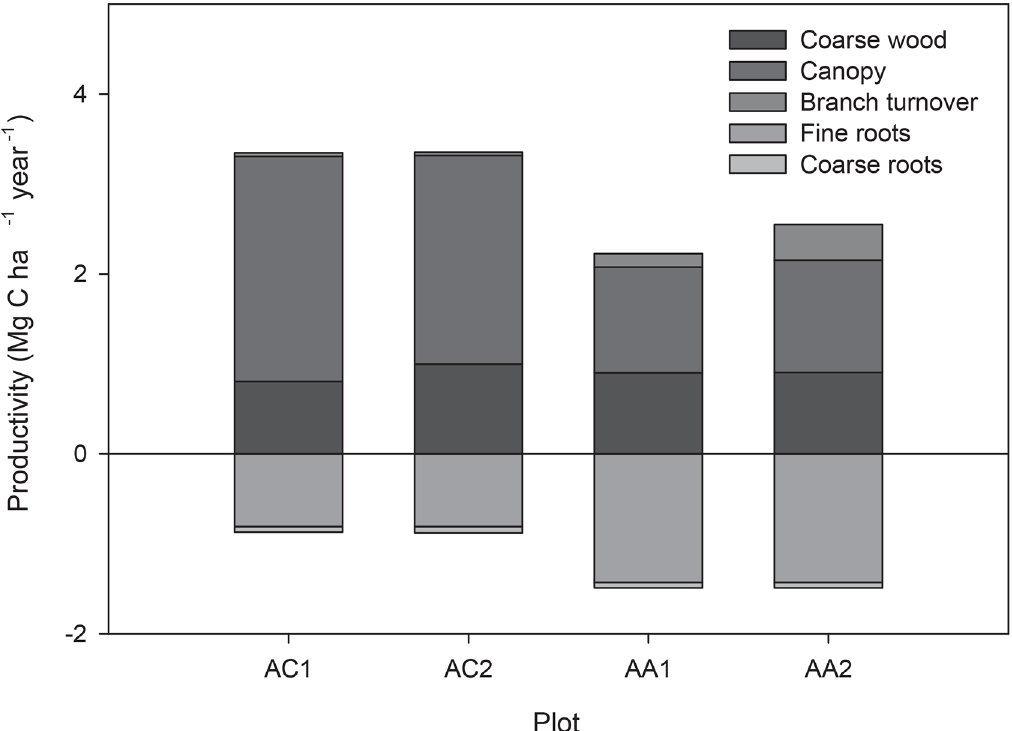
Fig 5. Total productivity per plot. Total productivity in Mg C ha -1 year -1 for the one-year period November 2011-October 2012 in the four studied plots and its allocation to the different components. Below-ground NPP is indicated as negative